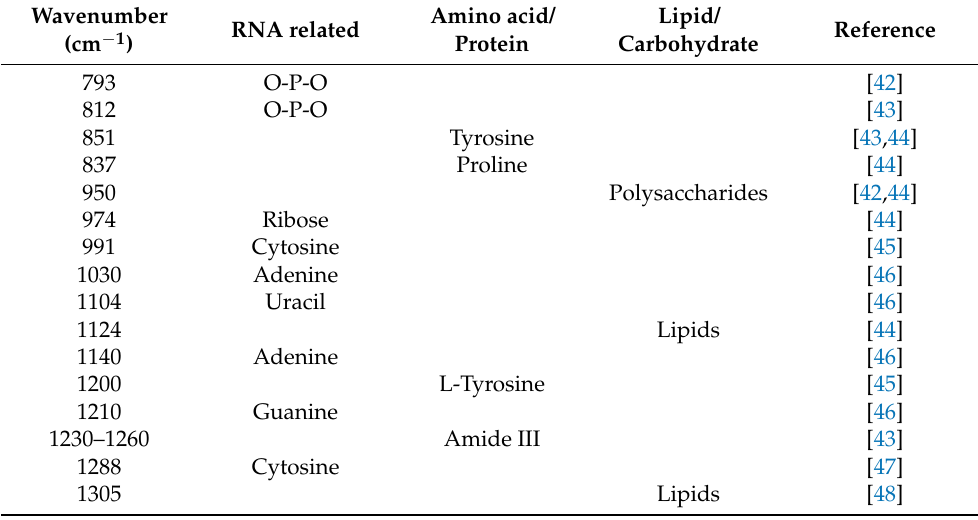
Figure 5. Vibrational signature. Raman spectra were obtained on the solution of viral particles adsorbed on the SERS substrate. Colored bands identify vibrational modes present in the sample. Table 1. Assignments of each band are presented on the SERS spectrum of CHIKV particles.